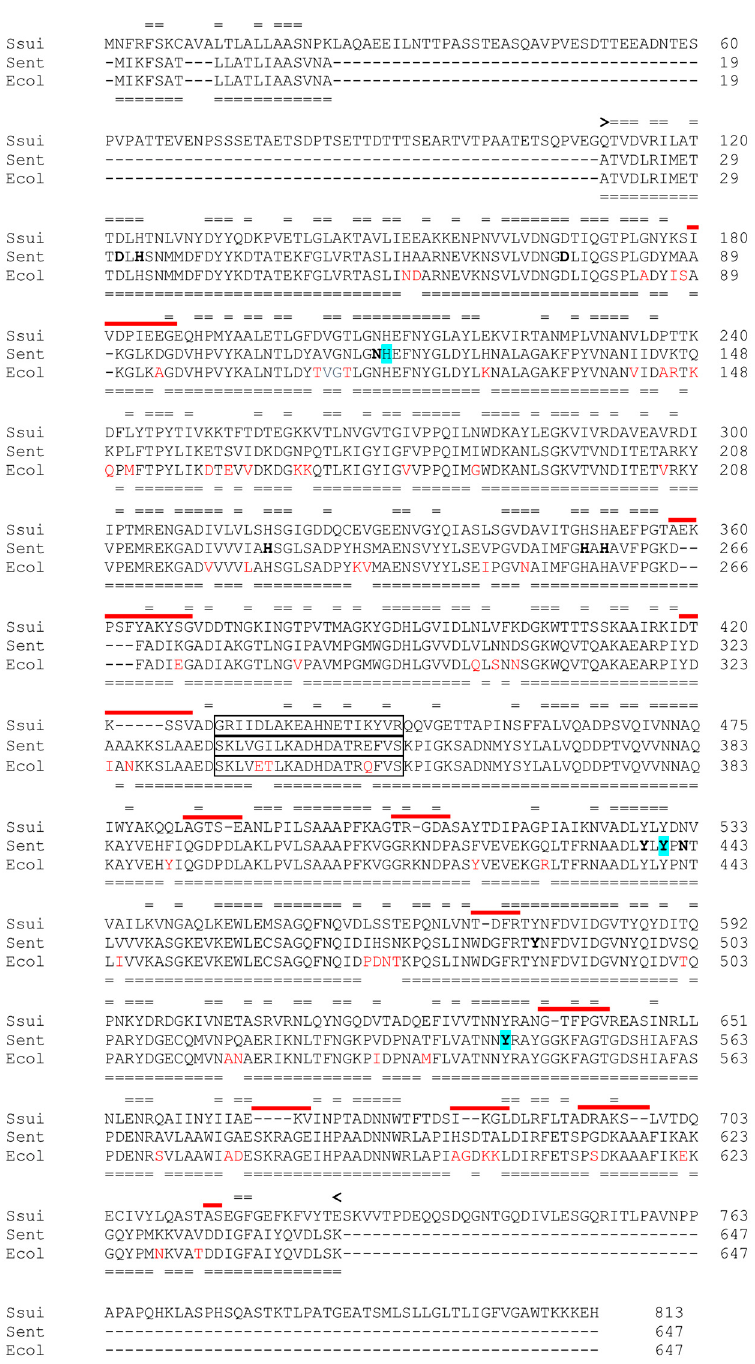
Figure 3. Sequence alignment of the proteins used in this study. The alignment was prepared with Clustal Omega online (https://www.ebi.ac.uk/Tools/msa/clustalo/; accessed 5 February 2023) with a few manual edits. The sequences correspond to NCBI Protein accessions: Ssui, AYV64543; Sent, P26265; Ecol, AKS04560 with the addition of the signal sequence. The symbol = above Ssui sequence and below Ecol one indicates identity with the Sent sequence. The recombinant proteins studied start and finish in the amino acids marked with arrowheads . The sequences within boxes correspond to the interdomain linkers between the N-terminal “metallophos” and the C-terminal “5_nucleotid_C” domains (see the structures shown in Figure 4). Bold-type amino acids in the Sent sequence are either those coordinated (in the metallophos domain) with the metal ions or located (in the 5_nucleotid_C domain) at ≤ 4 angstrom of a 3 ′ -AMP substrate modeled in the active site of E. coli CpdB. Shadowed in blue are His117, which has a catalytic role in enzymes of the metallophosphatase family, Tyr440 and Tyr544, which form a sandwich with the nitrogen base of sub-